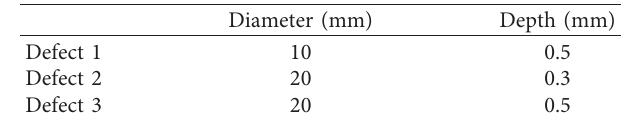
Figure 5: The honeycomb Sandwich structure with built-in defects. Table 1: Parameters of three defects.